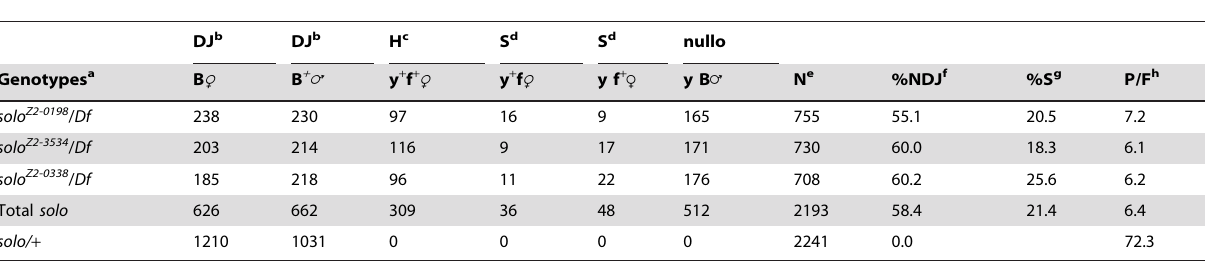
Table 1. X chromosome nondisjunction in solo females.